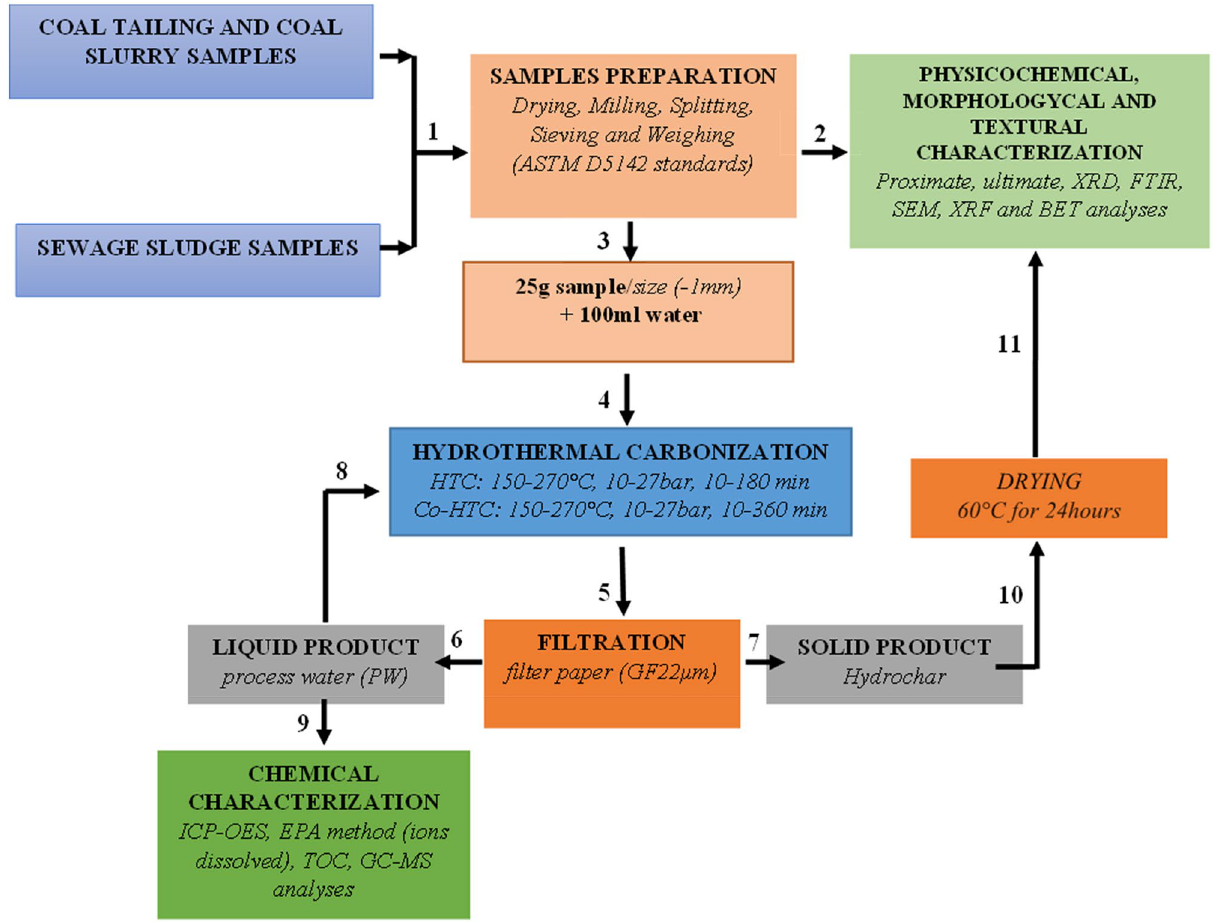
Figure 2. HTC and Co-HTC experimental